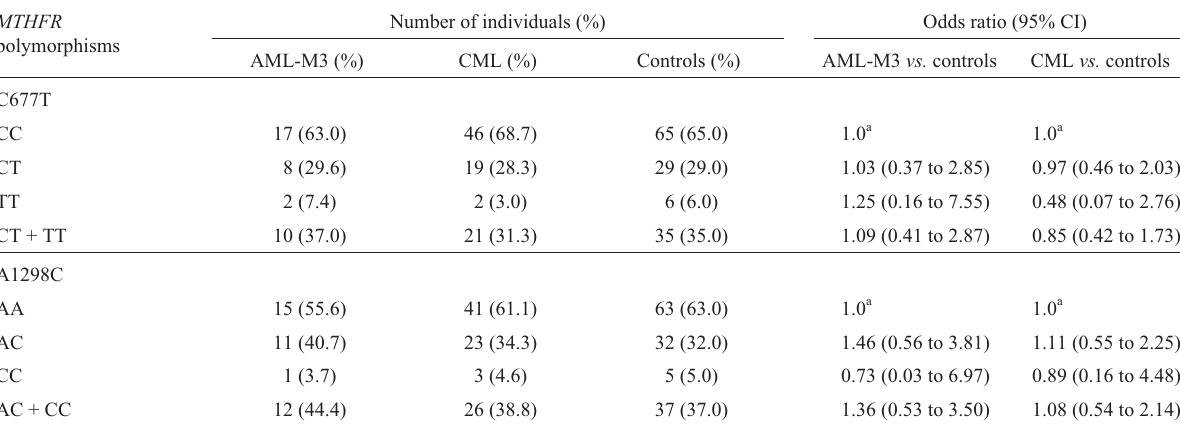
Table 1 - Methylenetetrahydrofolate reductase gene ( MTHFR ) C677T and A1298C polymorphisms genotype distributions among 67 patients with chronic myeloid leukemia (CML), 27 with acute myeloid leukemia FAB subtype M3 (AML-M3) and 100 apparently healthy controls. The odds ratio (OR) column shows the 95% confidence interval in